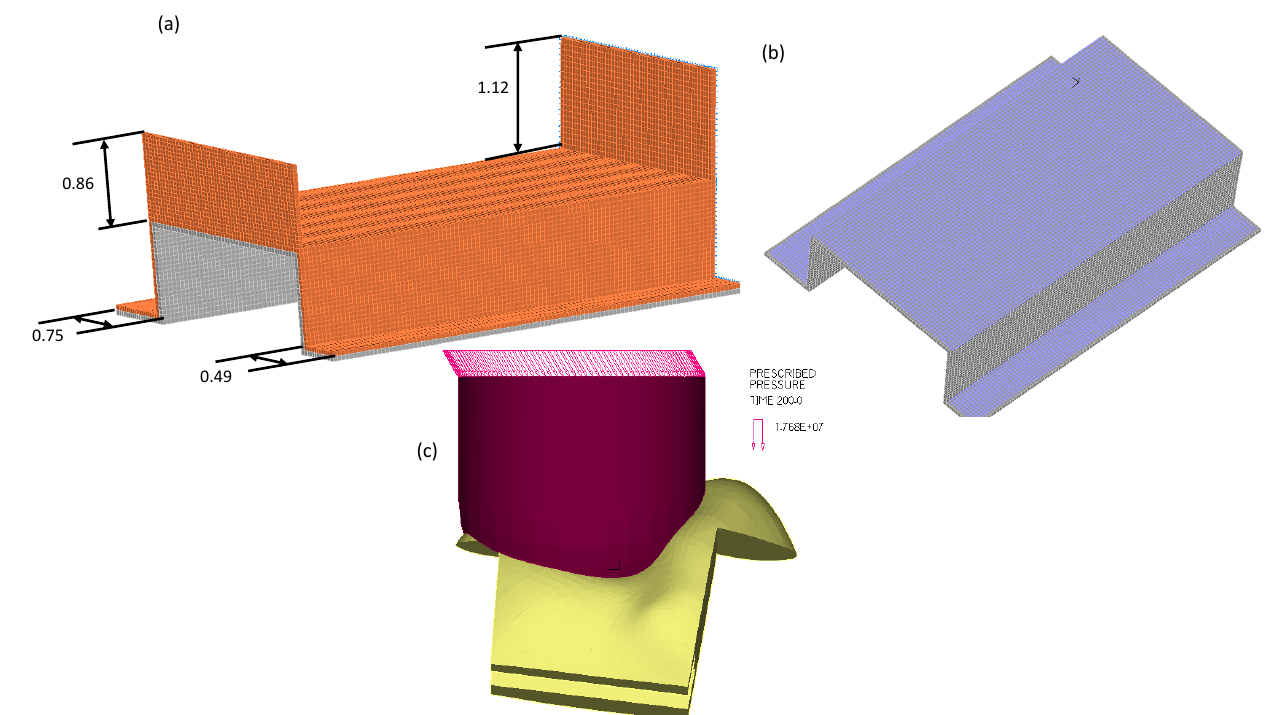
Figure 2. Cavity preparations. All dimensions are in millimeters. ( a ) Additional geometry that was created to allow CZM capability. ( b ) The three blue surfaces are used to identify the CZM. ( c ) The loading body has a prescribed pressure over the top surface, while the bottom surface is glued to the tooth surface.